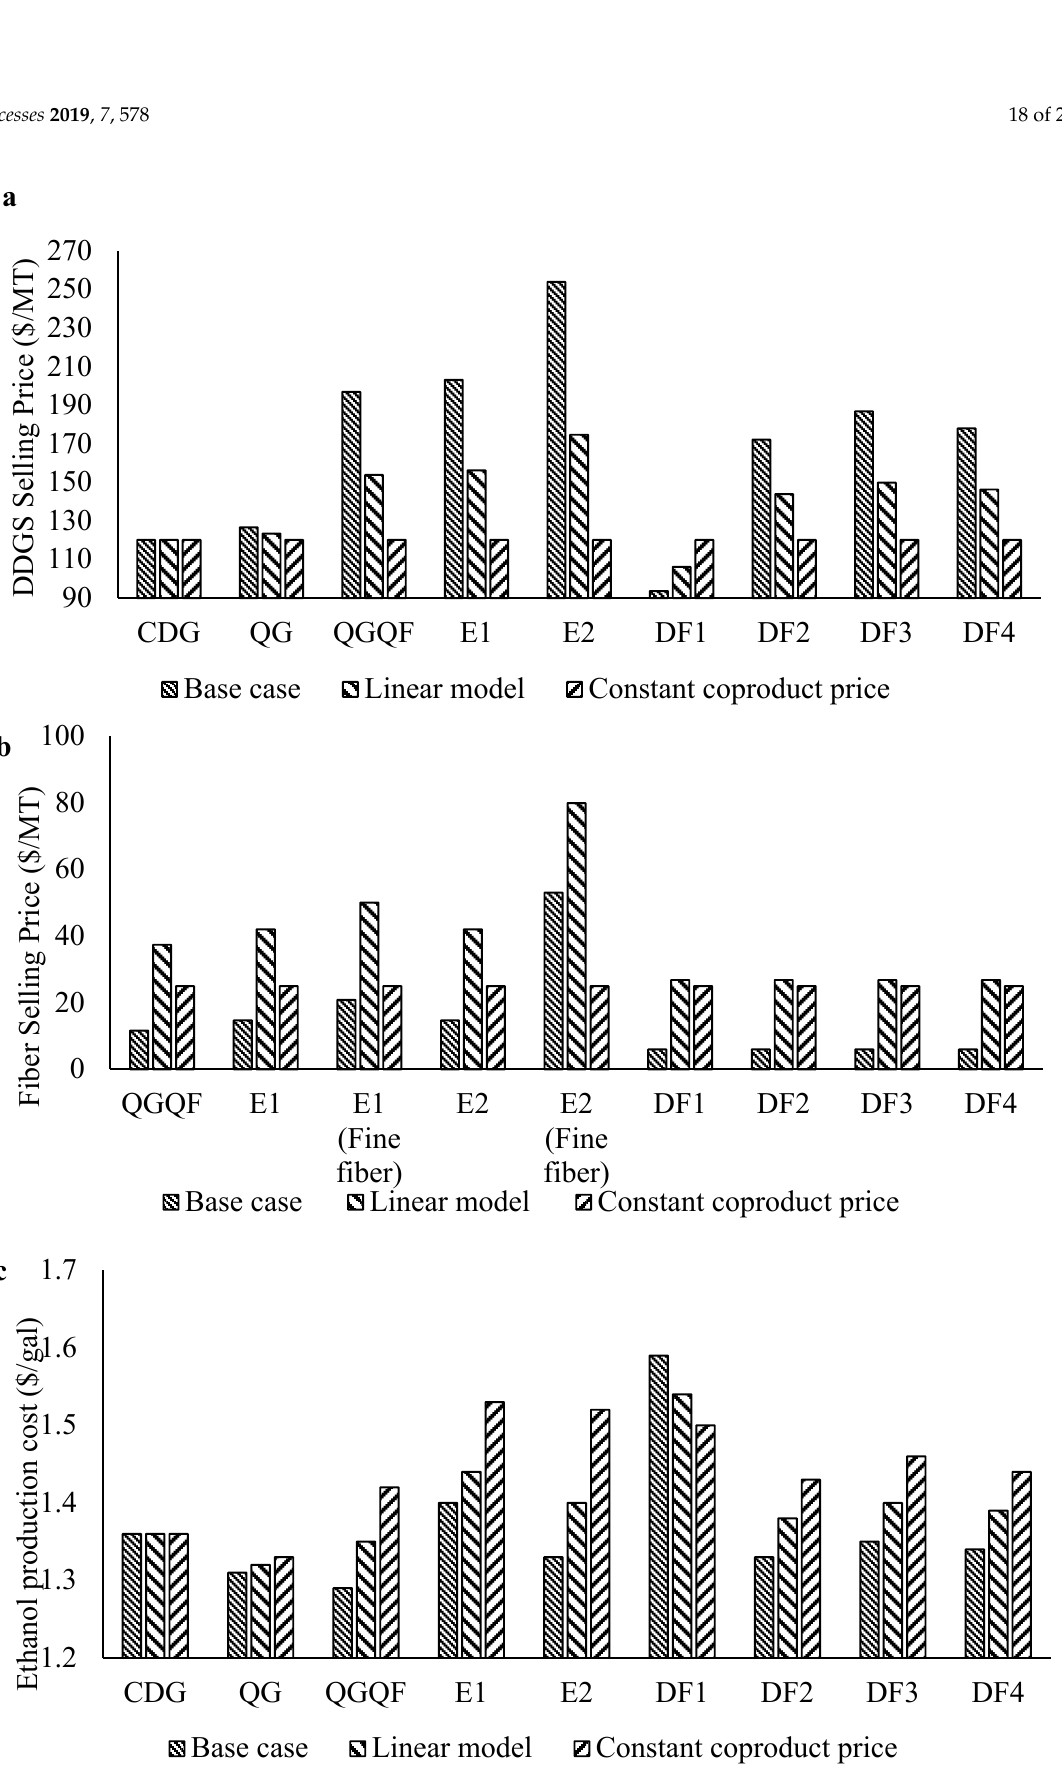
Figure 6. Effect of coproduct revenue model on ( a ) DDGS selling price; ( b ) fiber selling price and ( c ) ethanol production costs in conventional and modified dry grind processes.